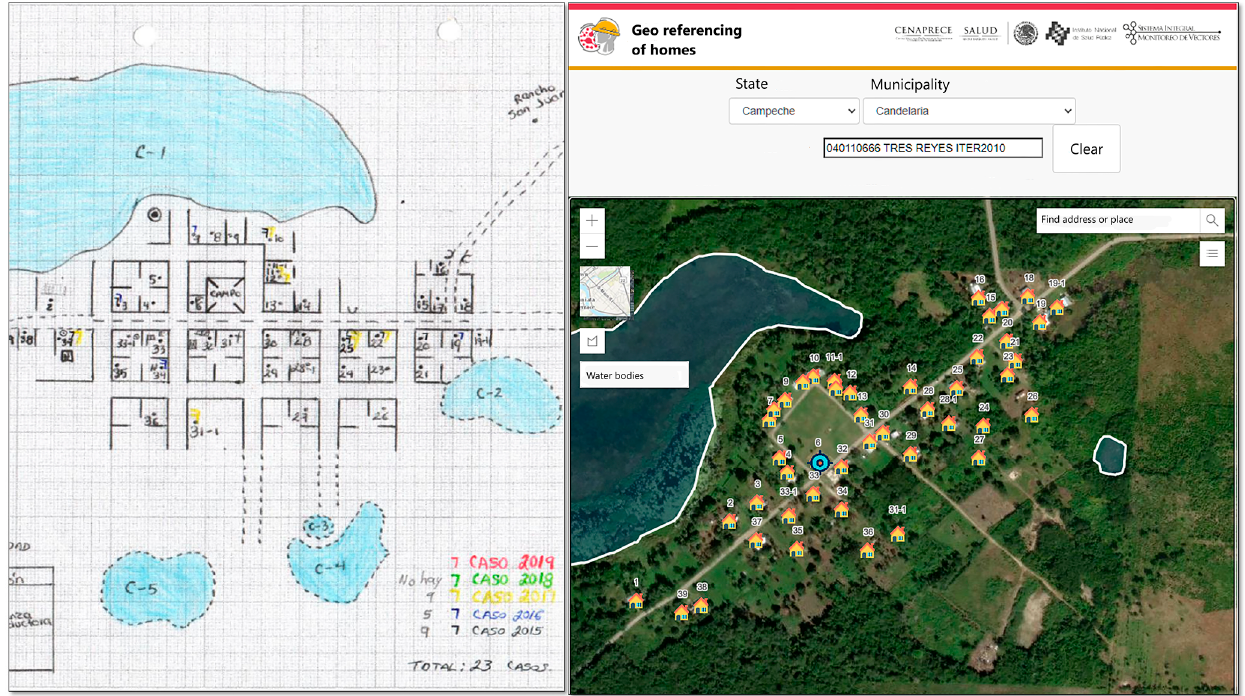
Figure 4. Georeferencing tool for dwellings and aquatic systems. In the houses the identification number is shown and in the white polygons the aquatic systems are shown. These elements can be related to epidemiological, entomological and vector control indicators.